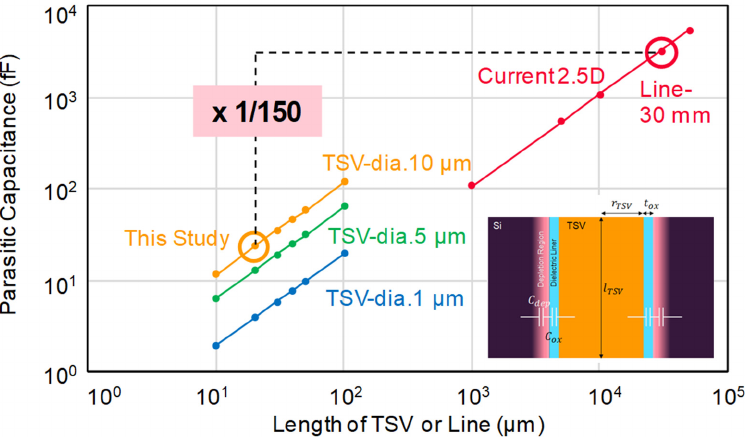
Figure 24. Parasitic capacitance as a function of the length of TSV or wiring line.